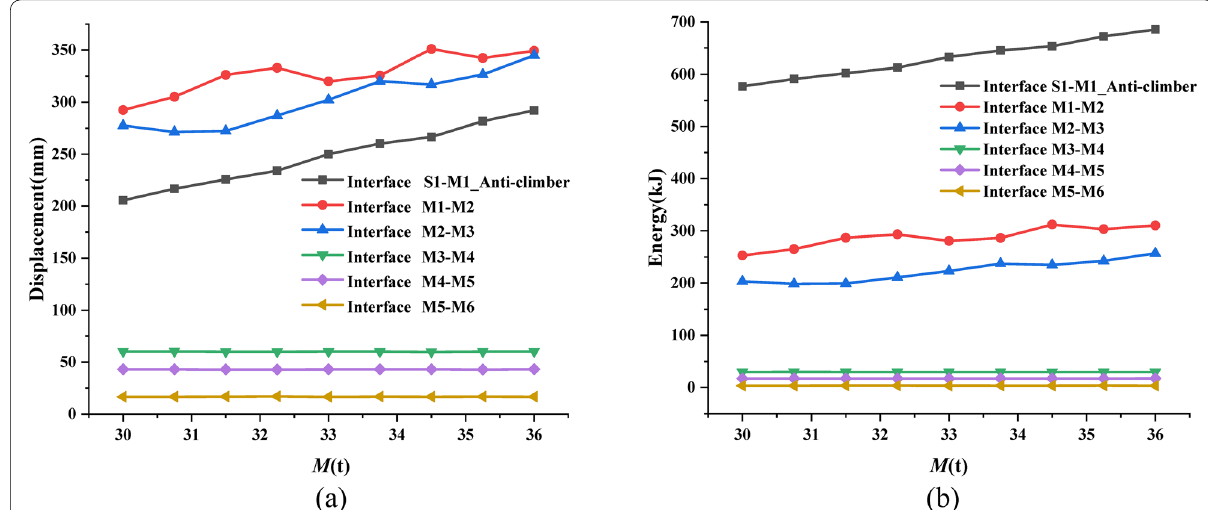
Figure 7 Influence of the vehicle design collision weight M on the collision response of the energy-absorbing devices: a compression displacement versus time curves, and b energy absorption versus time